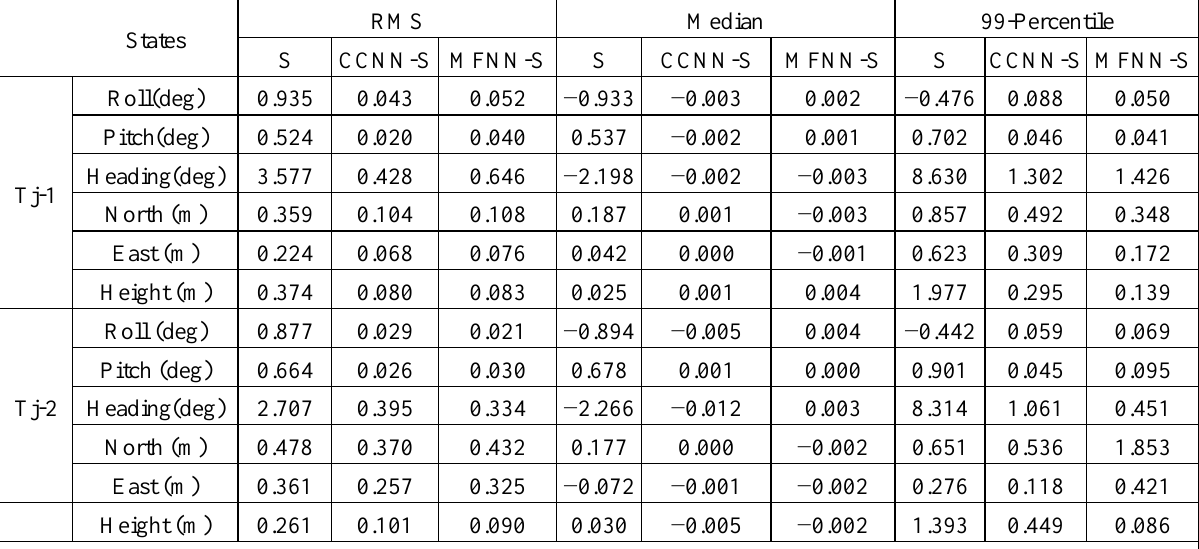
Table 4 . Statistical summary of the compensated positional and orientation